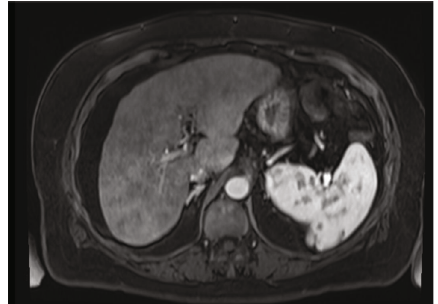
Figure 2: MRI demonstrating course texture (VIBE axial image post